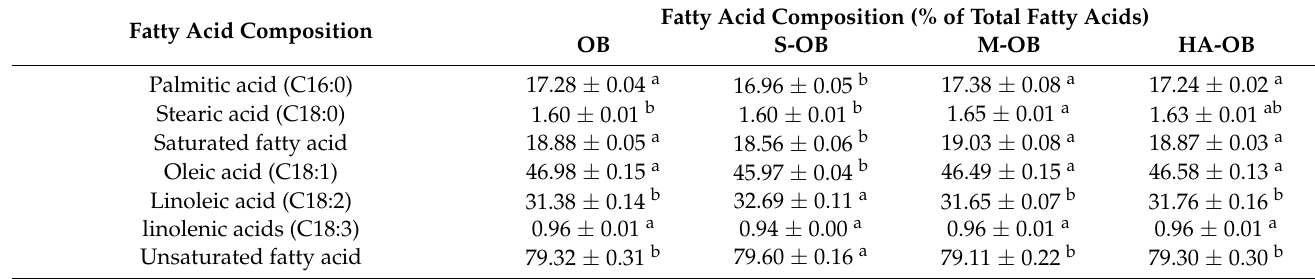
Table 4. Composition and content of fatty acids in oat bran after different